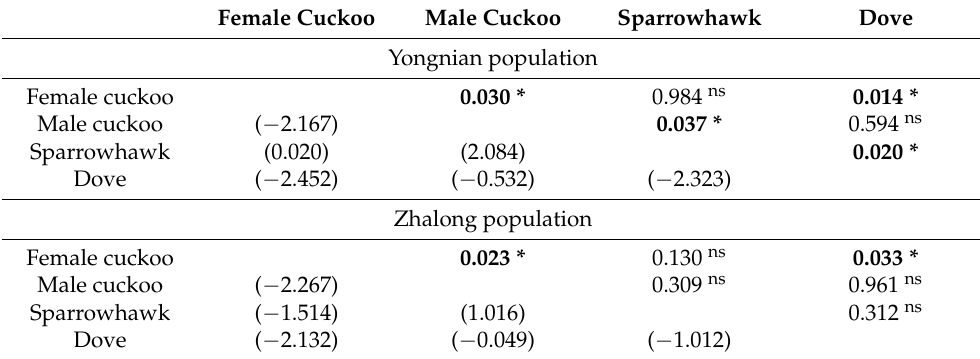
Table 3. The result of pairwise comparison for playback stimuli by Cox